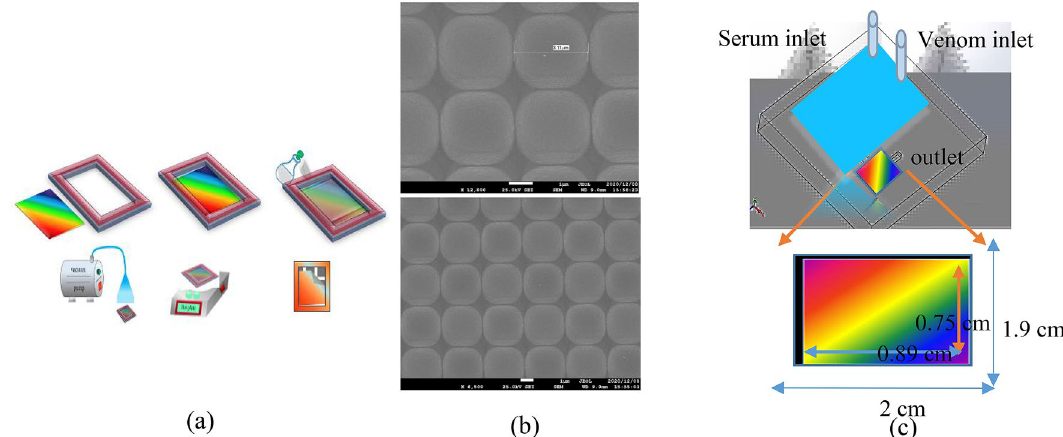
Figure 1. ( a ) schematic diagram of soft nanolithography, ( b ) SEM graph of samples and ( c ) main channel without (top) and with (bottom) plasmonic